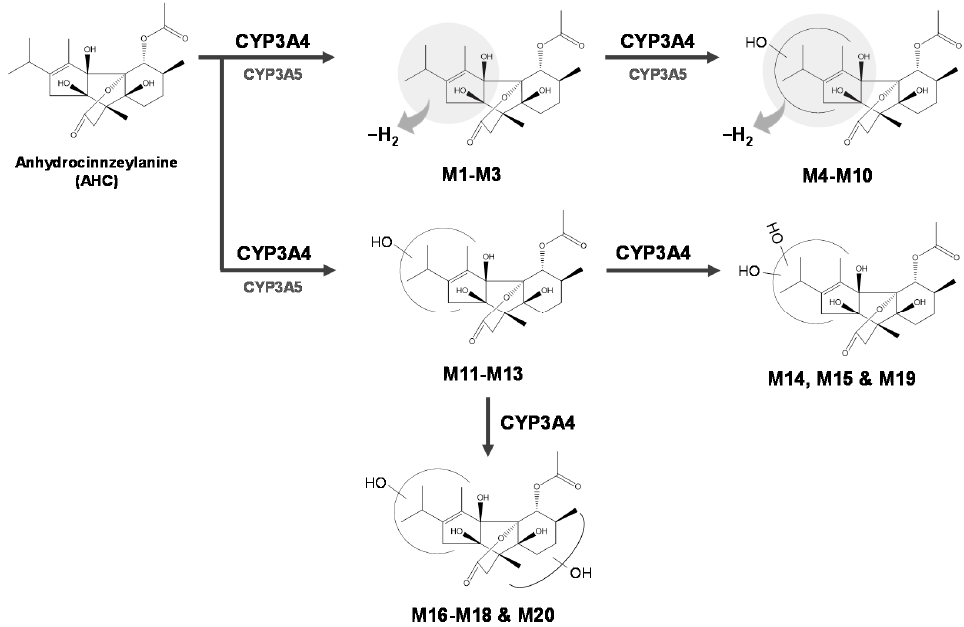
Figure 6. Postulated metabolic pathway of anhydrocinnzeylanine in human liver microsomes.